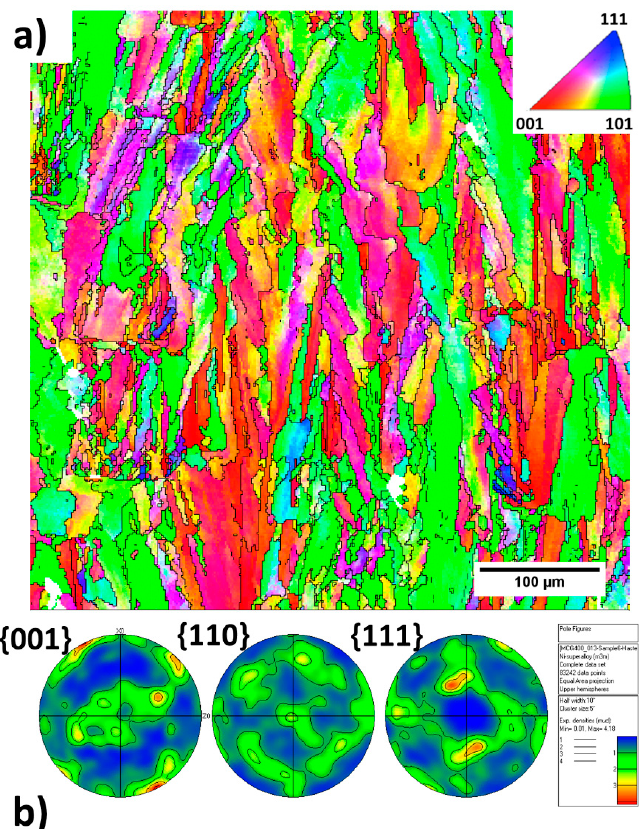
Figure 3. ( a ) Electron backscatter diffraction (EBSD) map taken from the central region of the as-built sample and ( b ) its corresponding pole